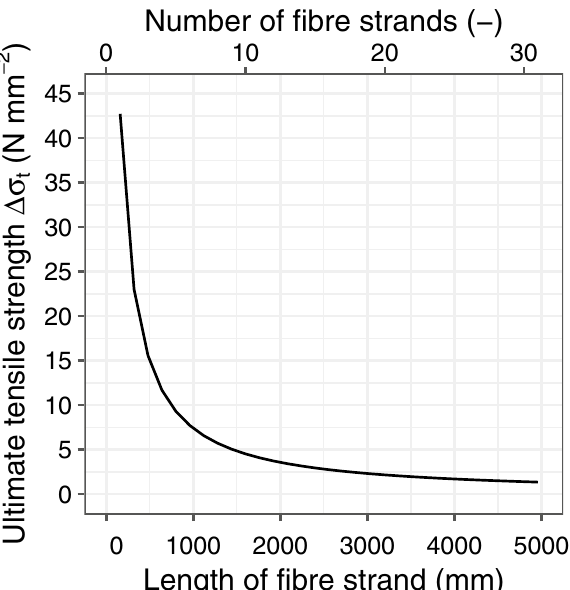
Figure 11. Margin of the 5%-Fractile values of n and (n-1)-fibre strands 15